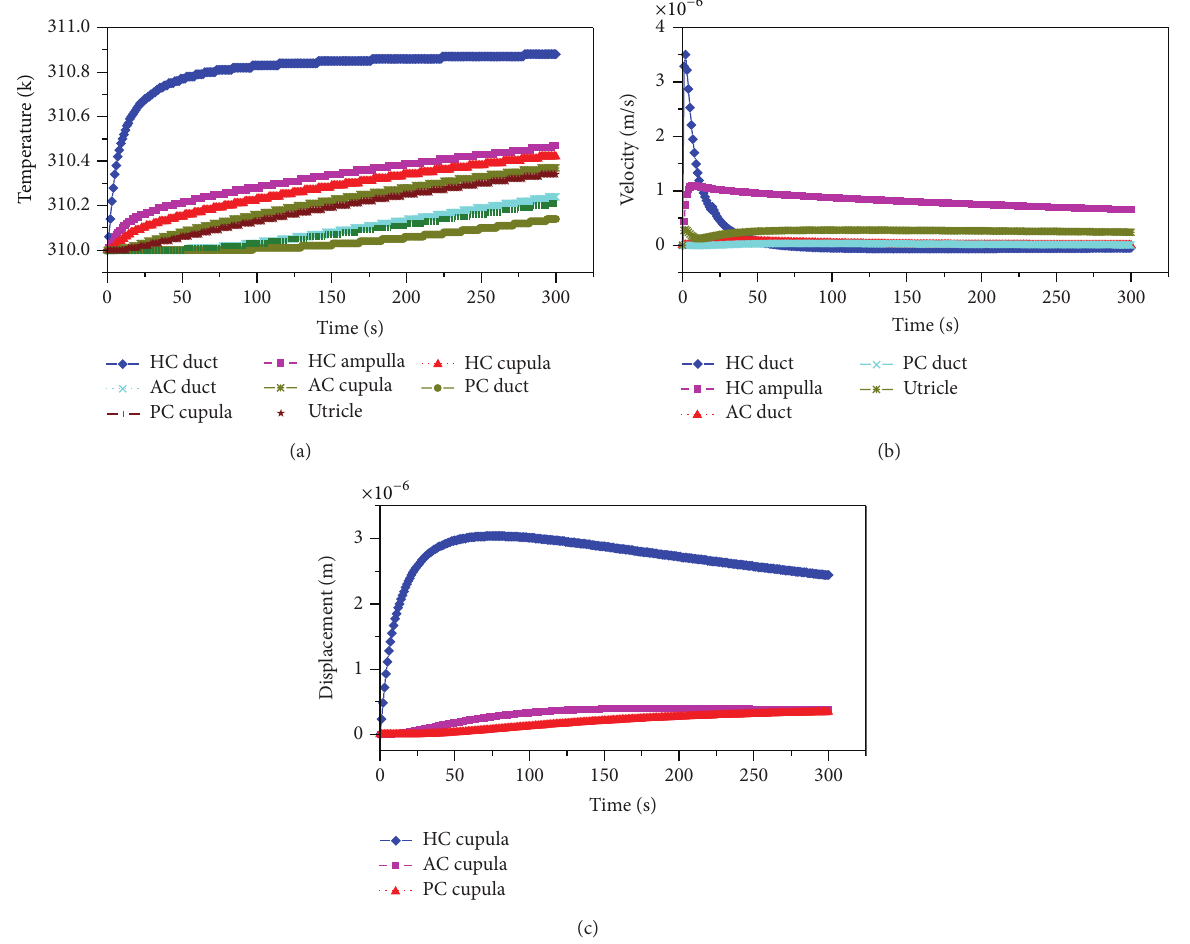
Figure 3: Time histories of the temperature (a), endolymph velocity (b), and cupula displacement (c) for a hot supine caloric test with Δ𝑇 = 1 ∘ C. The tested point in the HC duct is P1, in the HC ampulla is P2, on the HC cupula is P3, in the utricle is P4, in the AC duct is P5, on the AC cupula is P6, in the PC duct is P7, and on the PC cupula is P8. P1 ∼ P8 are defined in Figure 1(b). The velocity is positive for an ampullopetal flow in the HC duct and in the HC ampulla, for an ampullopetal flow in the AC and PC ducts, and for an utriculofugal flow in the utricle. Meanwhile, the deflection to the utricle side is positive for the HC cupula and to the canal side for the AC and PC cupulae.